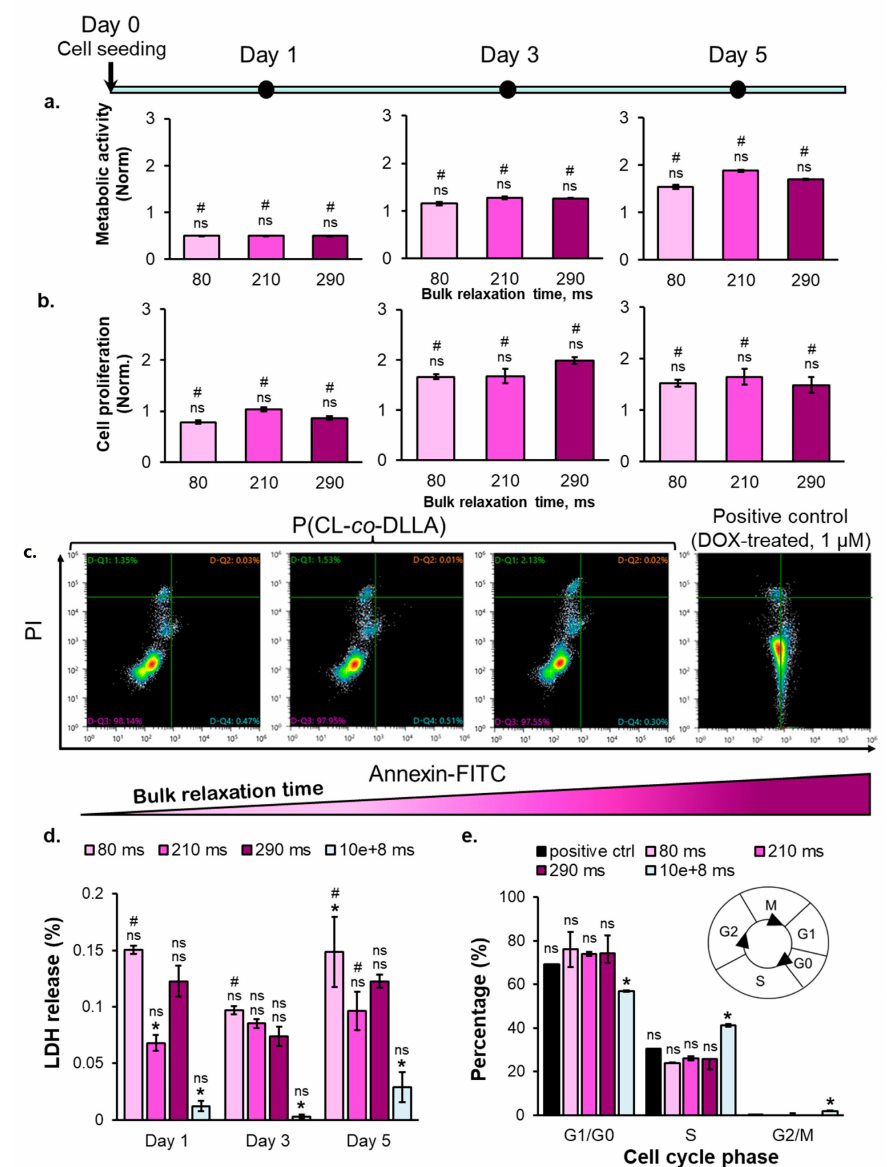
Figure 4. ( a ) The metabolic activity (NAD+ → NADH) of the cells on day 5, ( b ) the proliferation ability of the cells on day 5, ( c ) the expression of apoptosis & necrosis marker of the cells on day 5 on the substrates with various bulk relaxation time (from left to right: 80, 210, 290, and 10 8 ms), ( d )